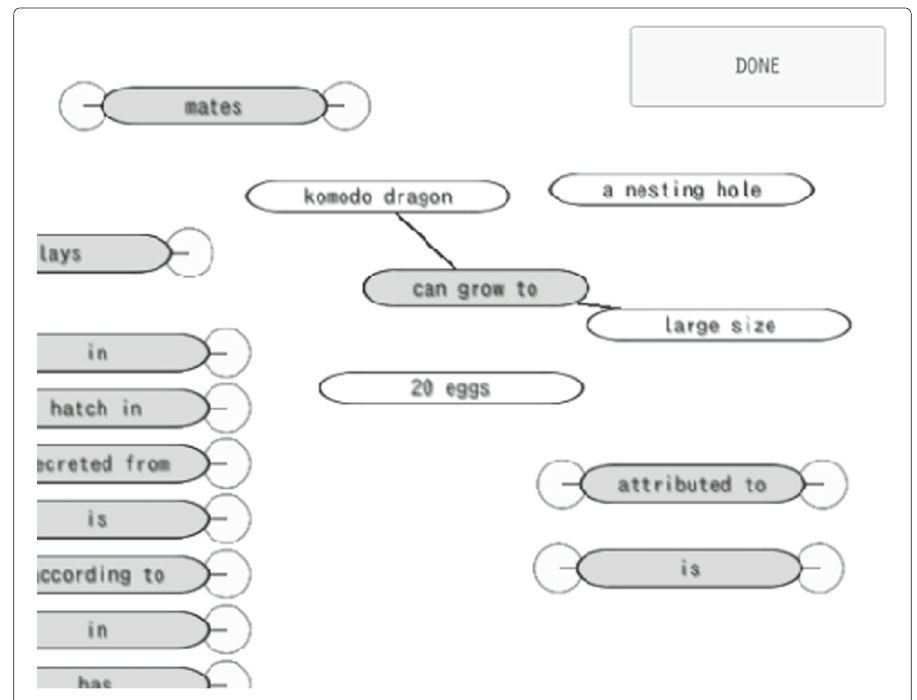
Fig. 1 The Kit-build interface